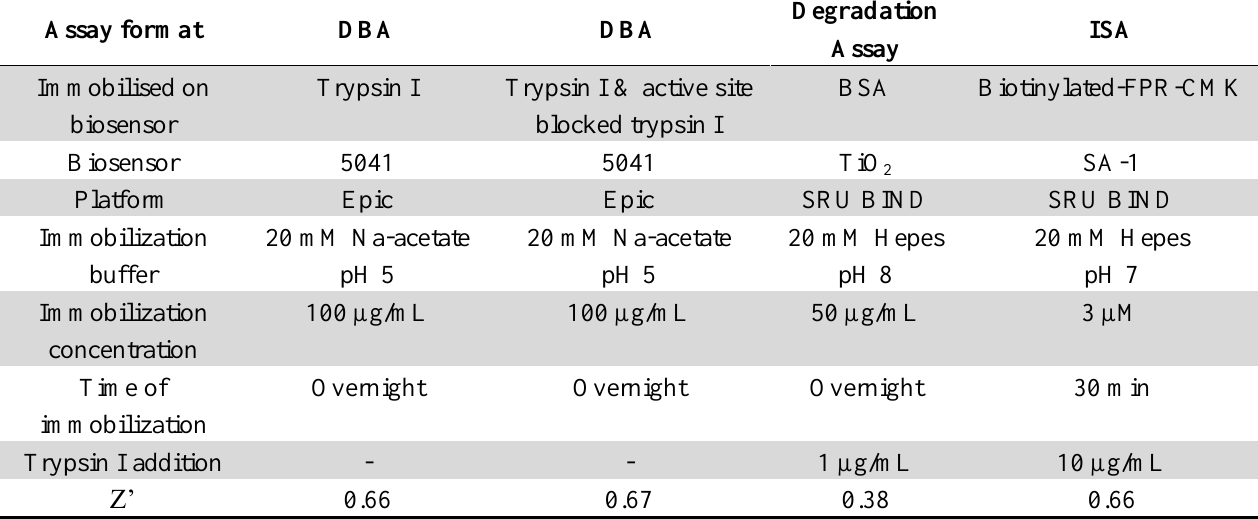
Table 1. A summary of the assay conditions of the assay formats on the microplate biosensors specifying microplates used, immobilization conditions and Z’ values of the resulting assays.